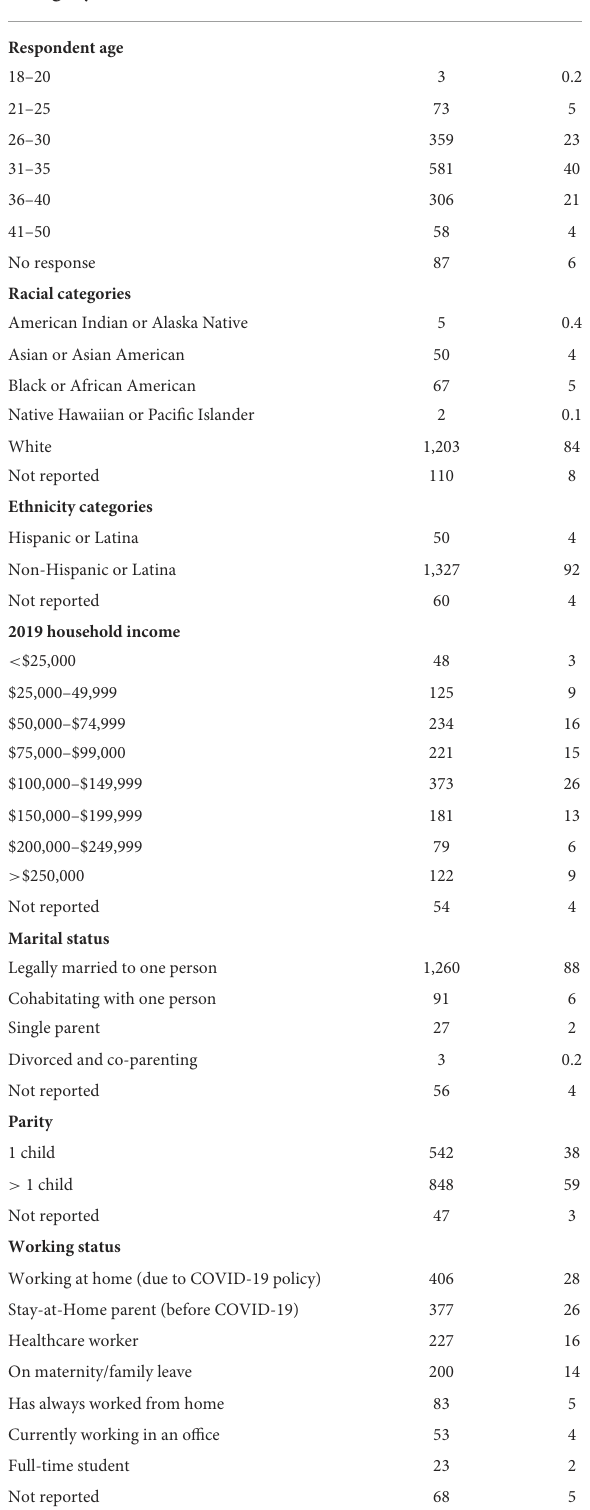
TABLE 1 Demographic characteristics of 1,437U.S. respondents, ages 18 and older, currently feeding their infant or young child who is 2 years of age or younger, March–May